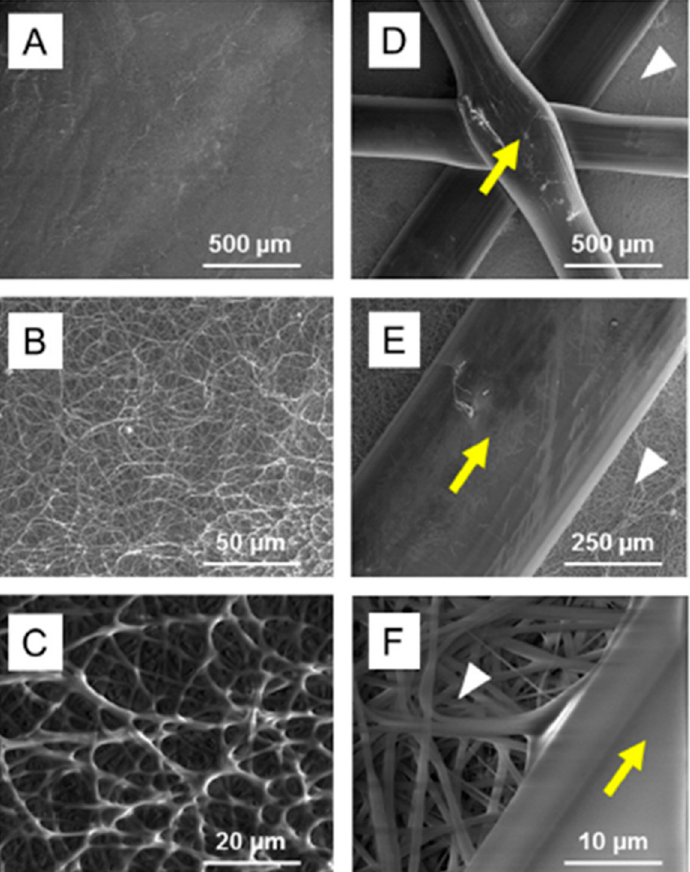
Figure 18. SEM images of reinforced electrospun scaffolds. ( A – C ) SEM images of the electrospun side of the reinforced scaffolds. The images show a uniform distribution of randomly oriented fibers. ( D – F ) SEM images of the 3D-printed side of the scaffolds. The high-magnification images ( F ) show that there is minimal damage to the electrospun fibers in the immediate vicinity of the 3D-printed PLA mesh. Yellow arrows depict the 3D-printed PLA. White arrowheads depict the PCL:gelatin scaffold (adapted with permission from [274]).